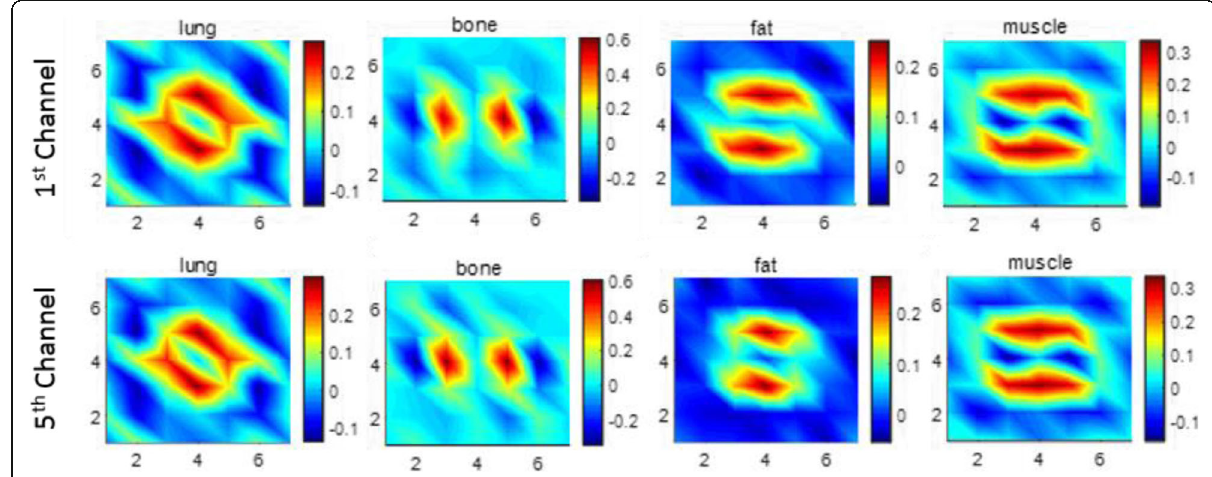
Fig. 2 The predicted markov random field coefficients for the four tissue regions of lung, bone, fat and muscle. The top panel is for the first channel. The bottom panel is for the last channel. From left to right, markov random field weights of lung, bone fat and muscle are shown